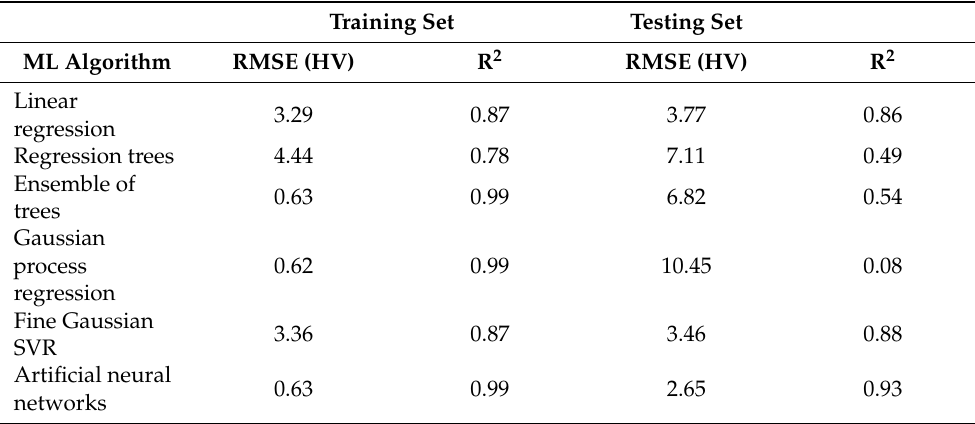
Table 3. Evaluation metrics of Hardness machine learning models for both the training and testing